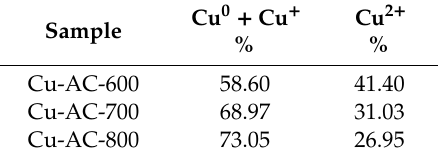
Figure 3. XPS survey spectra of Cu-AC-600 ( a ), Cu-AC-700 ( b ), and Cu-AC-800 ( c ). Table 2. Proportion of Cu species for different Cu-AC samples.